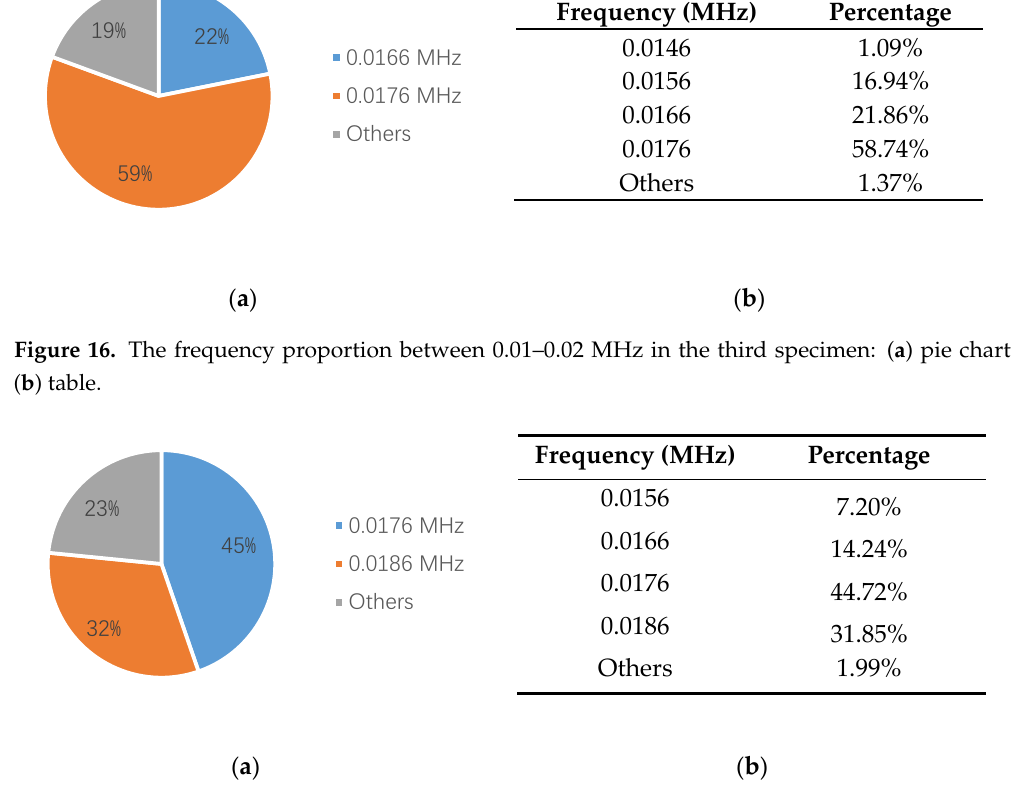
Figure 17. The frequency proportion between 0.01–0.02 MHz in the fourth specimen: ( a ) pie chart; ( b ) table.